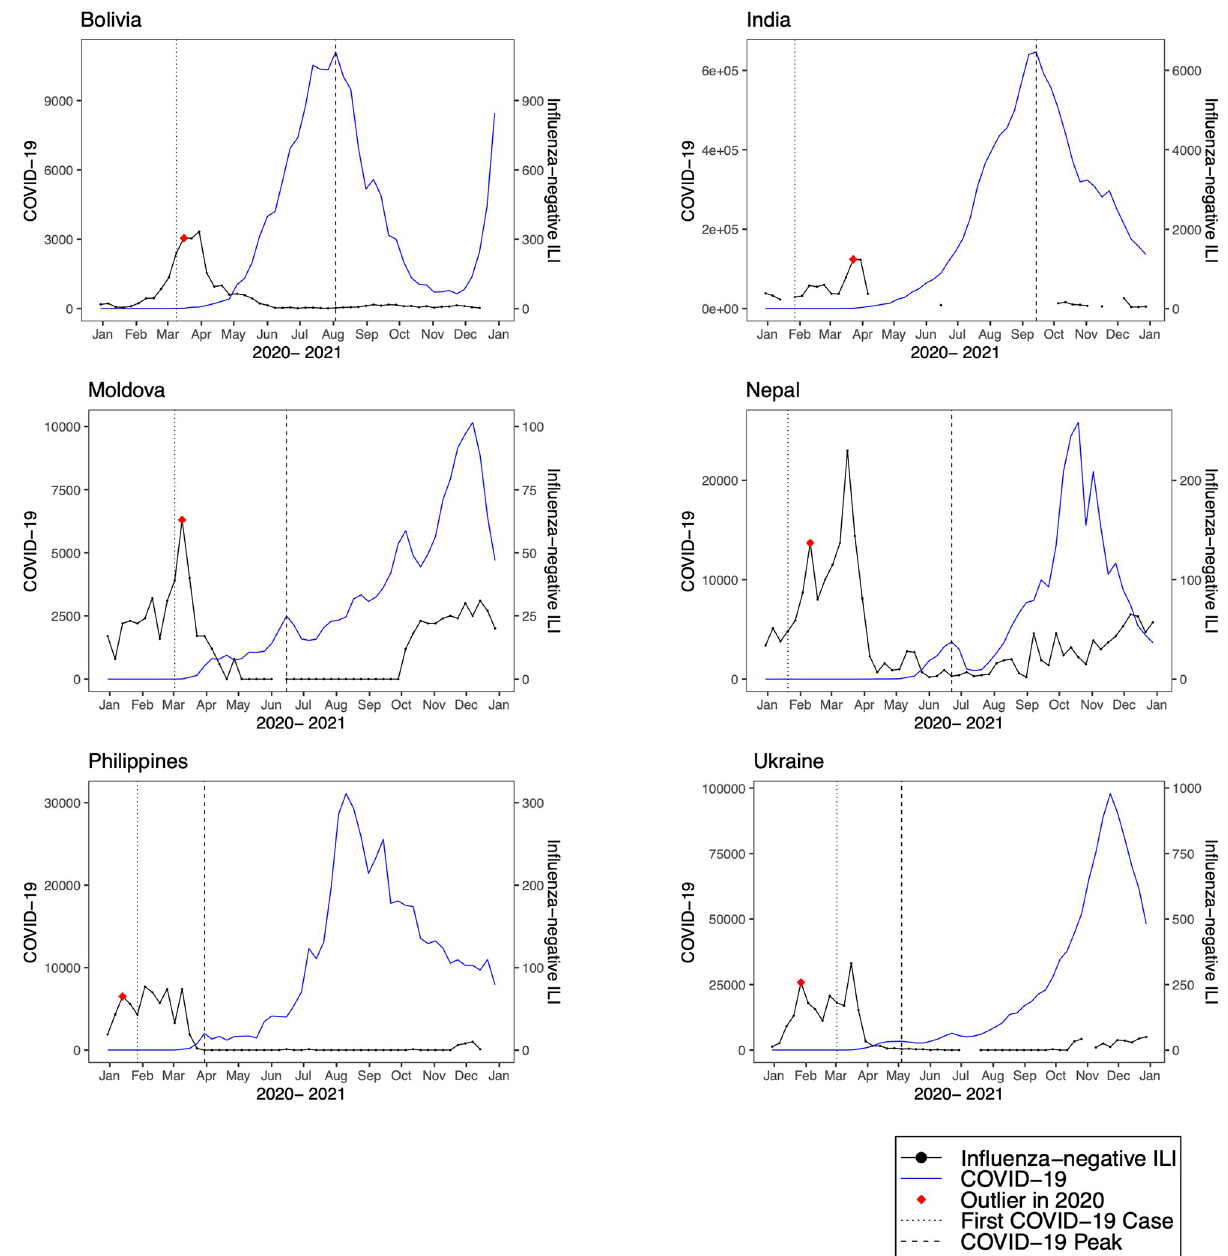
Fig 7. Observed trends in COVID-19 compared to influenza-negative influenza-like illness (ILI) in lower-middle-income countries. Trends in reported COVID-19 cases (blue line) and influenza-negative ILI cases (black line) during 2020. The vertical dotted black line indicates the week of the first COVID-19 case, the vertical dashed line indicates the week of the first COVID-19 peak, and the red diamond indicates the first detected influenza- negative ILI outlier in 2020.